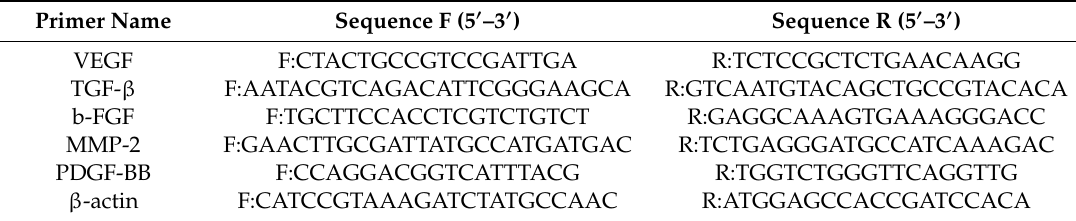
Table 2. Oligonucleotide primers used in the